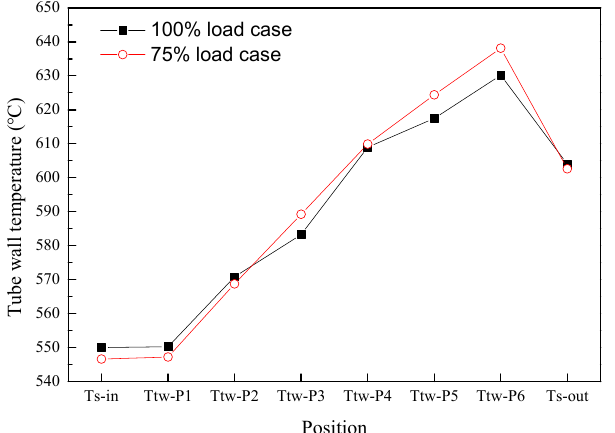
Figure 11. Calculation results of the temperature distribution of serpentine and feature points loca- tions; ( a ) tube wall temperature distribution of serpentine; ( b ) locations of P1 to P6.